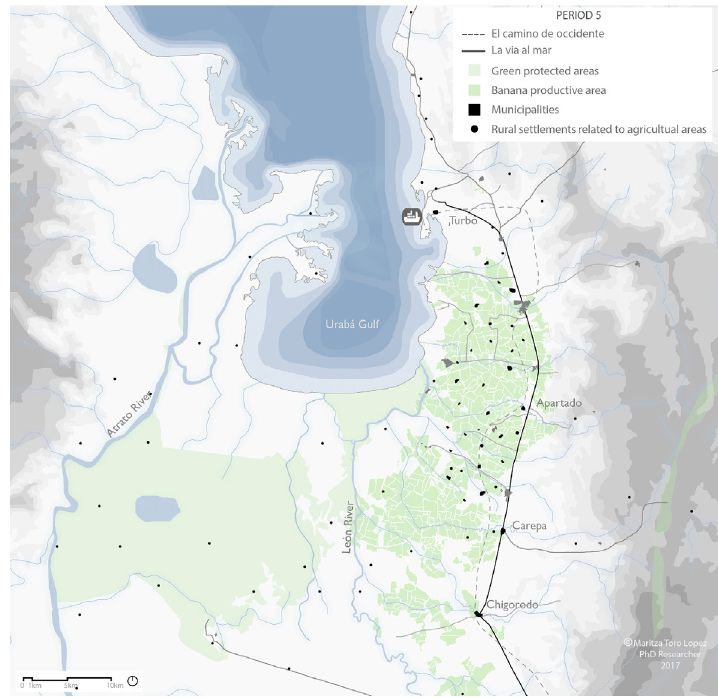
Fig. 6. Period 5: The consolidation of the banana